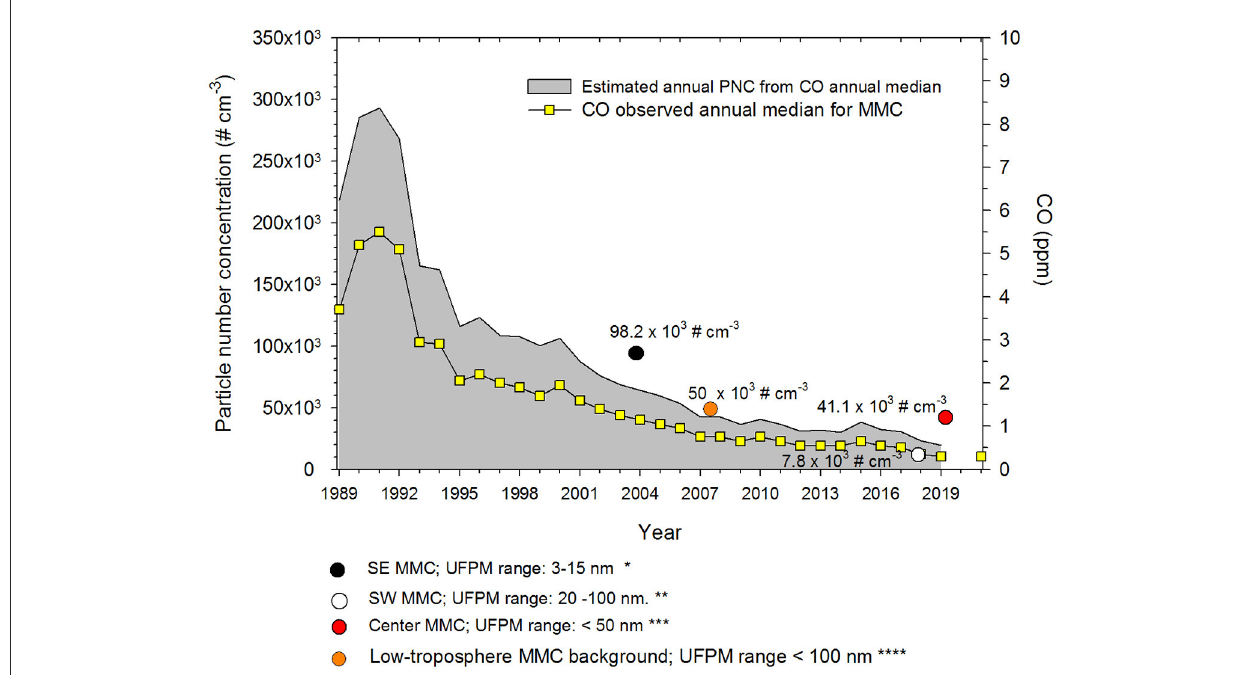
FIGURE2 Trends of estimated PNCs and the associated annual medians of 1-h average CO for five representative monitoring stations of the MMC from 1989 to 2021. The colored circles in the figure correspond to the medians of PNCs measured by the authors referenced in (51*), (52**), (53***), and (54****). CO data source: